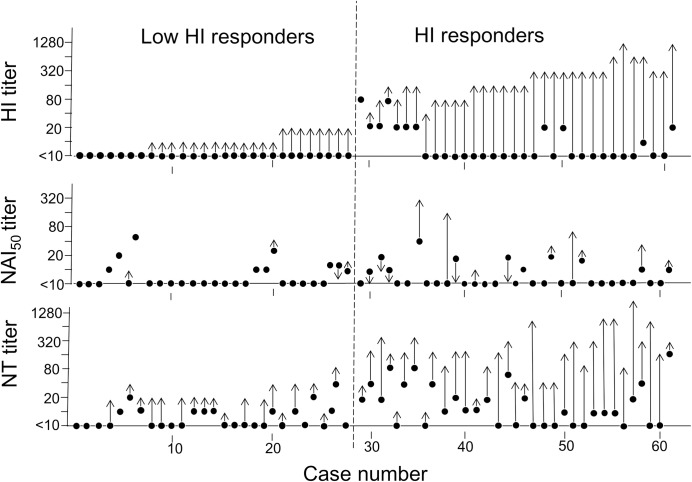
A shift of haemagglutinin inhibition, neuraminidase inhibition and neutralisation titers in individual paired sera of 61 vaccinees.Vaccinees’ case number (abscissa) and the titers of the sera (ordinate). Solid circles, pre-vaccination titers; arrowheads, post-vaccination titers. Only circles were cases without a shift between the paired sera. The dotted line separates the haemagglutination-inhibition in low responders (HI-LR) and responders (HI-R) groups.